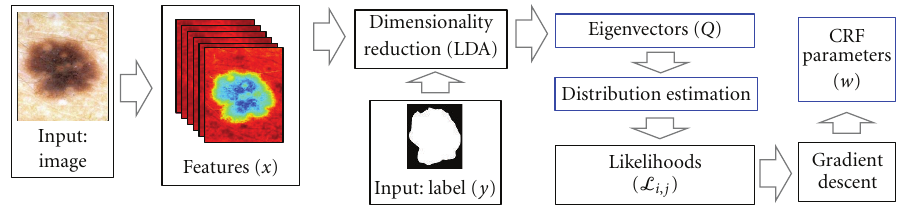
Figure 4: The training phase of our CRF model. We follow the same procedure as in our PP model up until the posteriors are estimated. We then calculate pixel likelihoods and use these as node features in our CRF model. We infer CRF parameters using gradient descent.